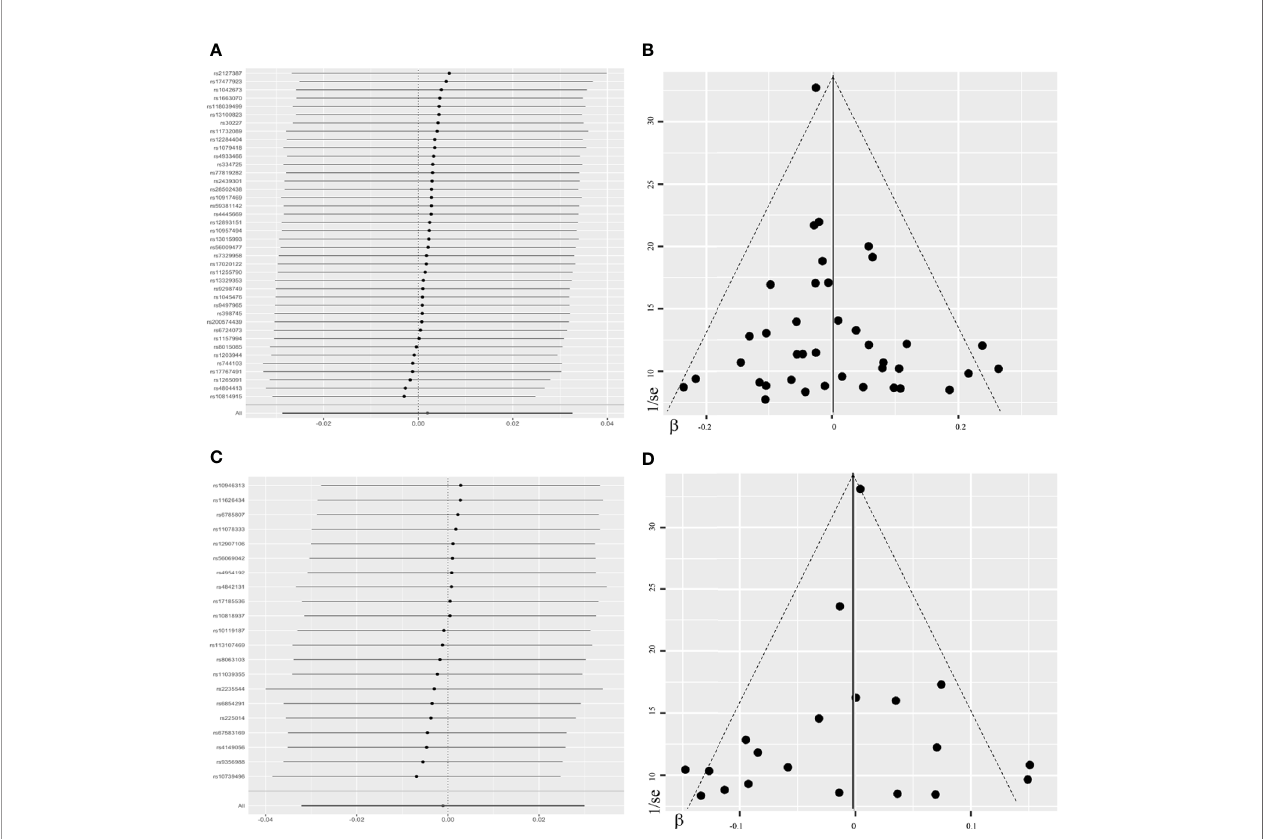
FIGURE 4 | Leave-one-out plots and funnel plots in the sensitivity analyses. The leave-one-out plot (A) visualized how the causal estimates (point with horizontal line) for the effect of maternal TSH on birth weight were in fl uenced by the removal of single variant. The funnel plot (B) illustrated the overall symmetry of causal estimates across all instrumental variables. Each point denoted corresponding inverse standard error against the individual causal estimate. The leave-one-out plot (C) and funnel plot (D) in the sensitivity analysis of FT4-birth weight relationship were presented likewise. FT4, free thyroxine; TSH, thyroid stimulating